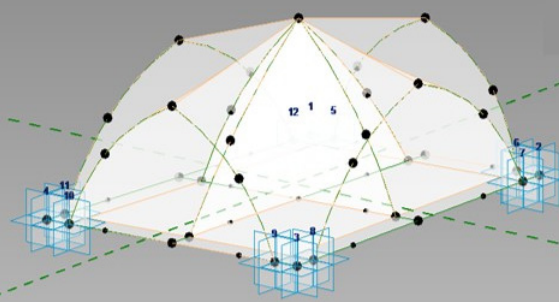
Figure 8. Parametric modelling of “pointed crossvault with variable generatrix line”.